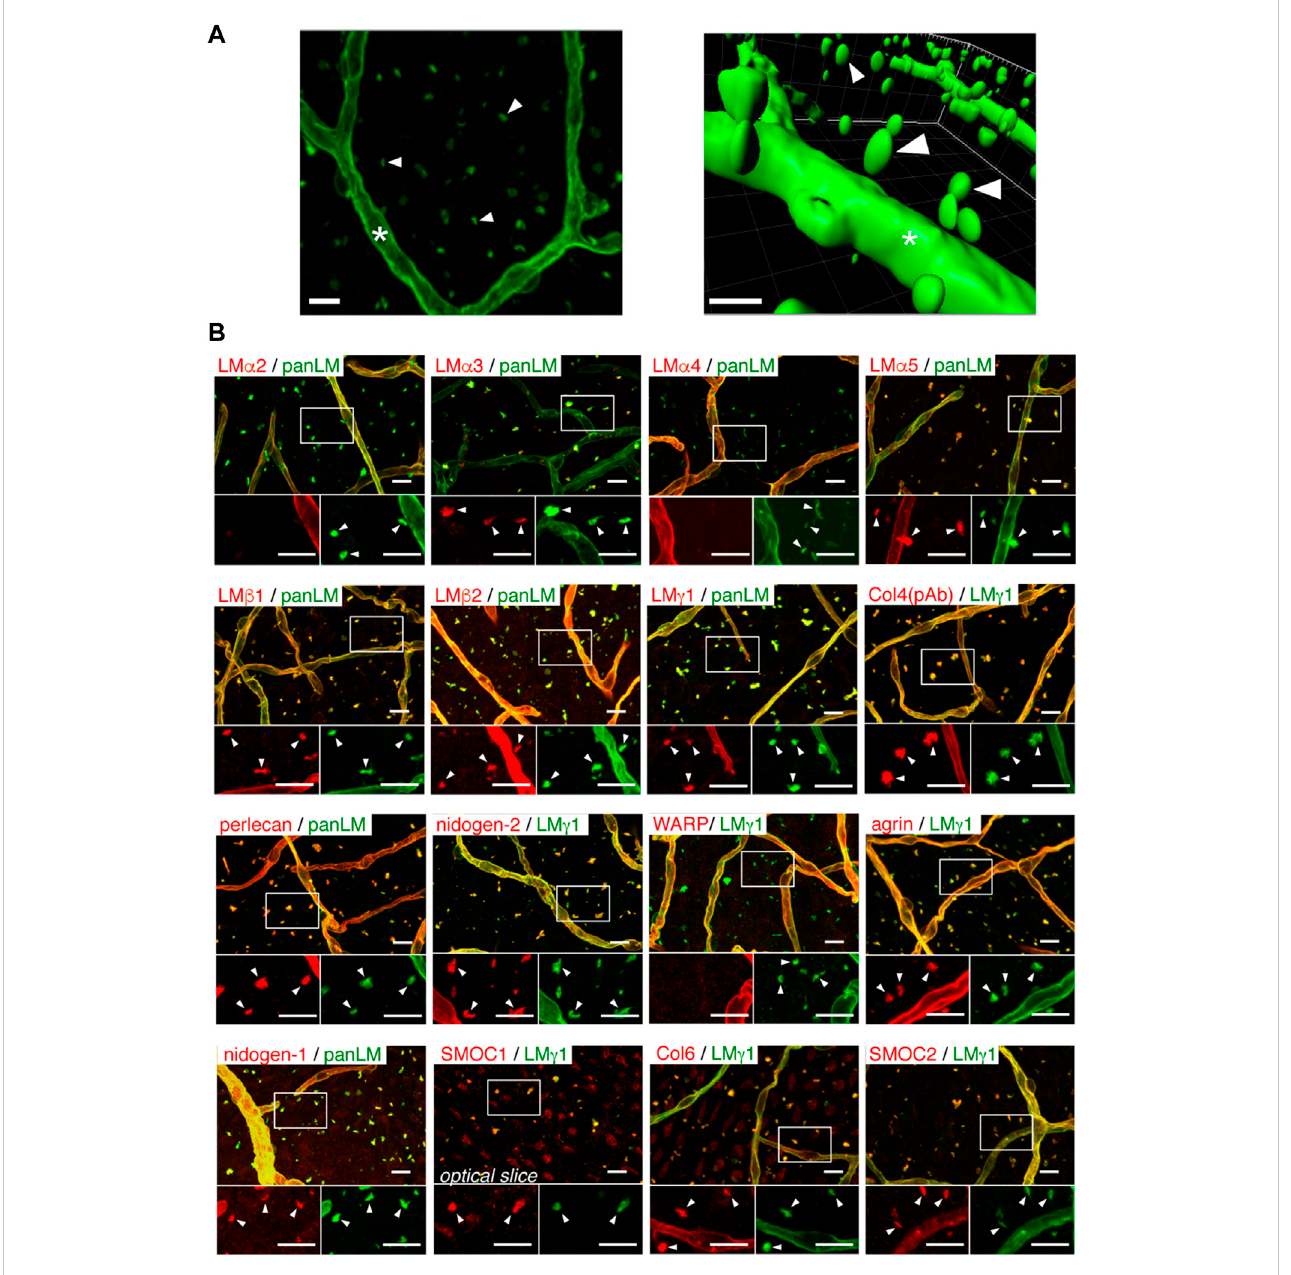
Fractones are visible as BM speckles in whole-mount V-SVZ immunostaining. (A) Whole-mount images of a mouse V-SVZ stained with an anti-panLM antibody. Left, image from the ventricle. Right, three-dimensional reconstruction of the left panel. (B) Whole-mount V-SVZs were labeled with antibodies against individual BM proteins (red) together with anti-panLM or anti-LM γ 1 antibodies (green). Each panel shows a merged image (top) and higher- magni fi cationimages(bottom)ofthetwochannelsintheboxedarea.Asterisks,bloodvesselBMs;arrowheads,speckledBMs.Scalebars,10 μ m.Adapted from (Sato et al., 2019) with